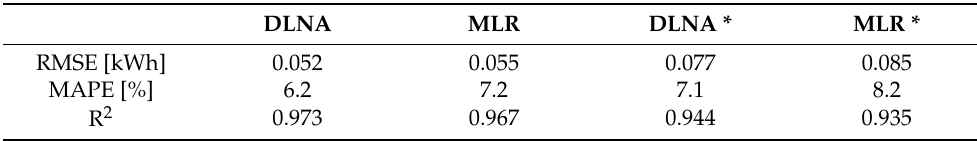
Table 5. MAPE and RMSE errors for two models.